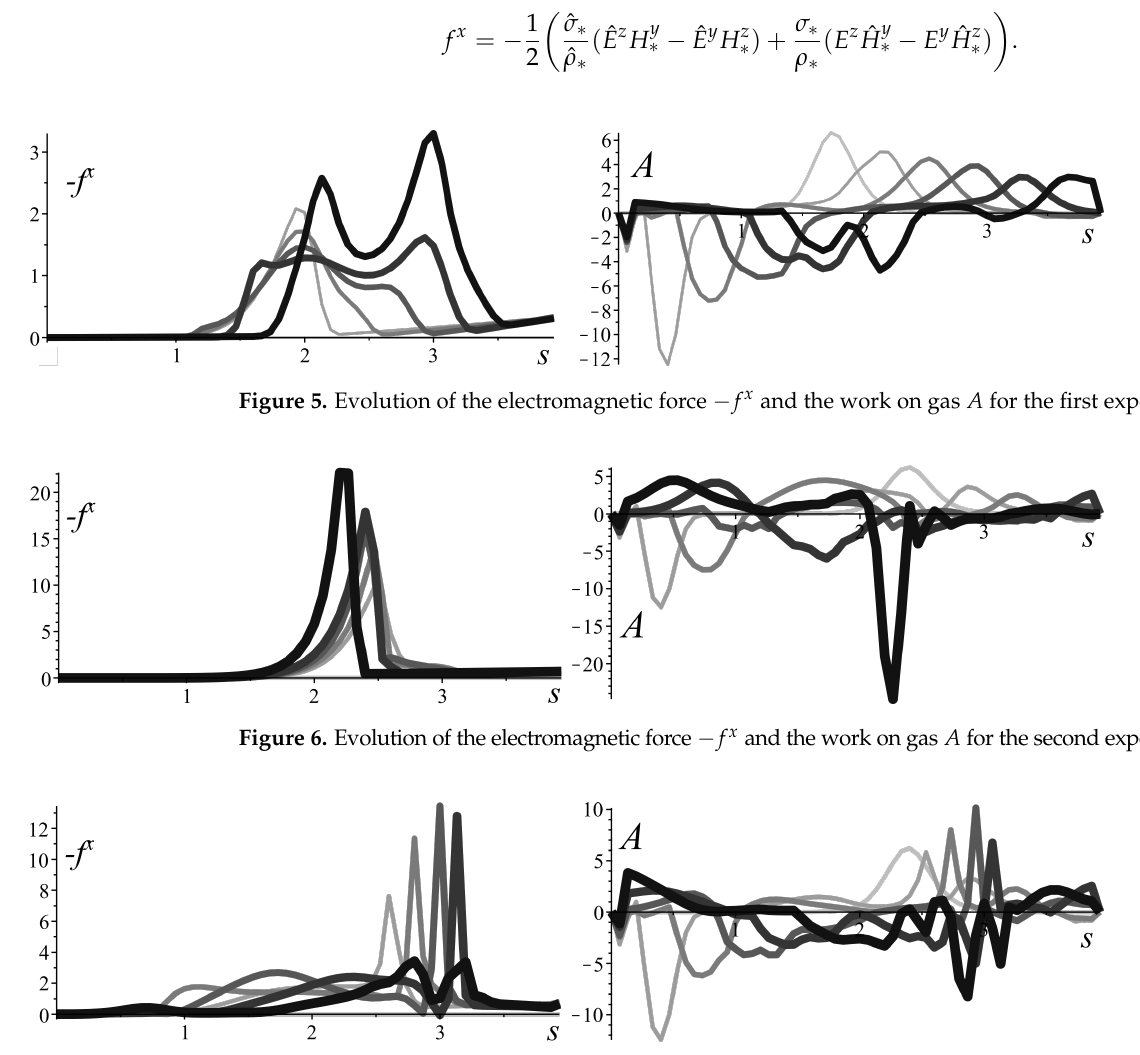
Figure 7. Evolution of the electromagnetic force − f x and the work on gas A for the third experiment.